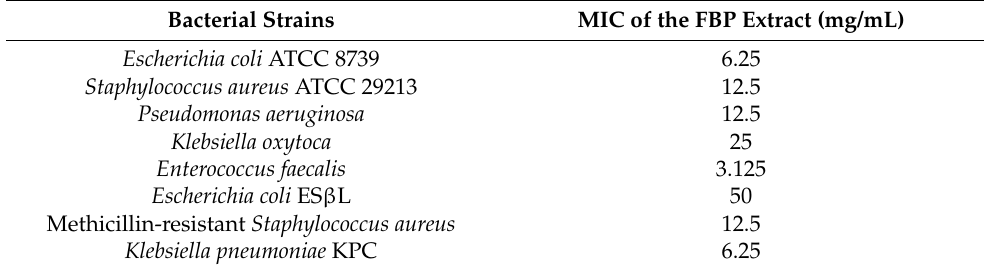
Table 4. Minimum inhibitory activity (MIC) of the FBP extract against bacterial strains. Bacterial